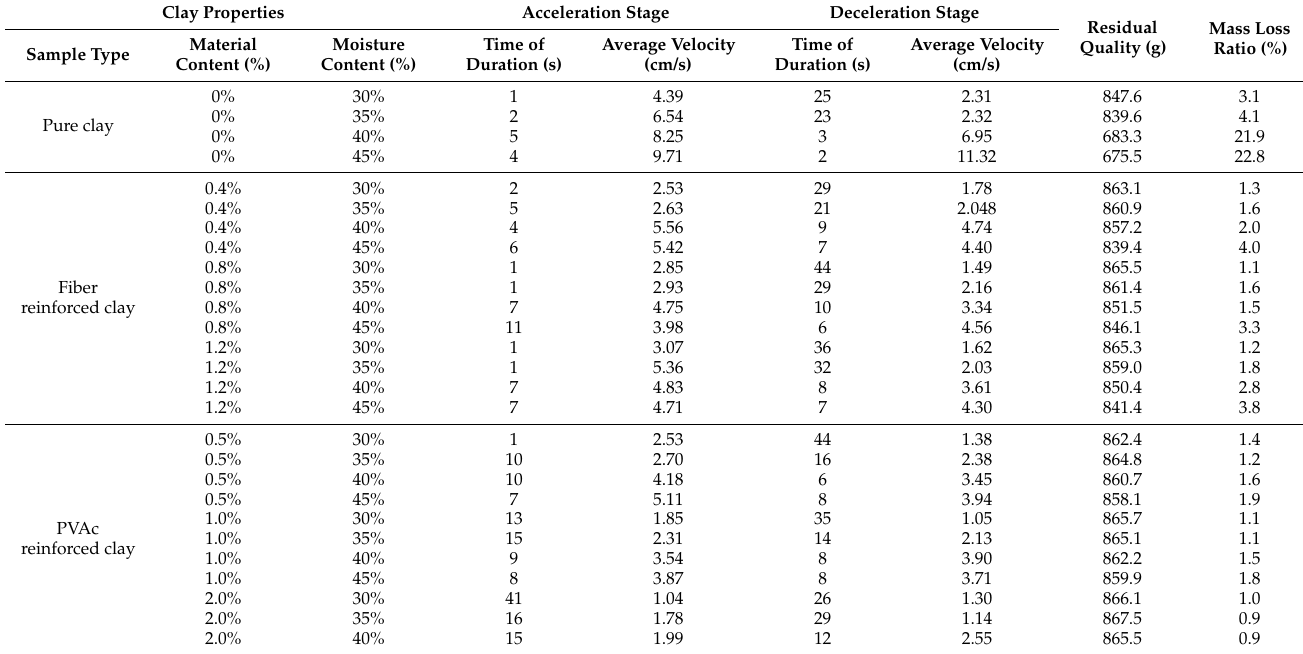
Table 6. Clay sample descriptions of model